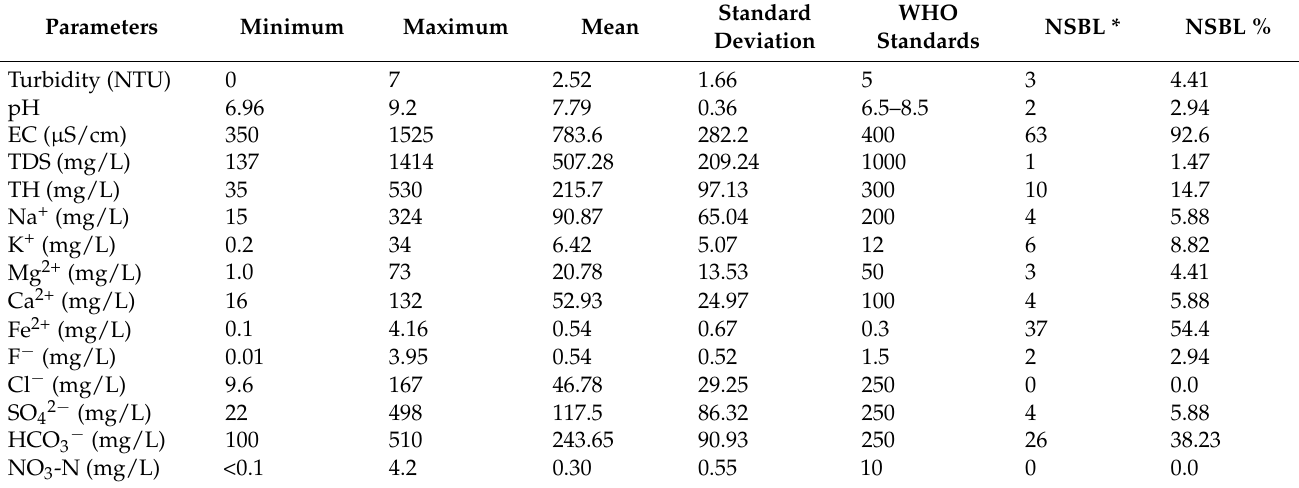
* Number of samples beyond (WHO) limits. The turbidity value varied between 0 and 7 Nephelometric Turbidity Units (NTUs) with an average value of 2.52 NTUs, and only three samples showed high turbidity. The higher turbidity in the groundwater system of the area belonged to a shallow-depth well due to contamination exposure compared with the deep aquifer and mid-depth